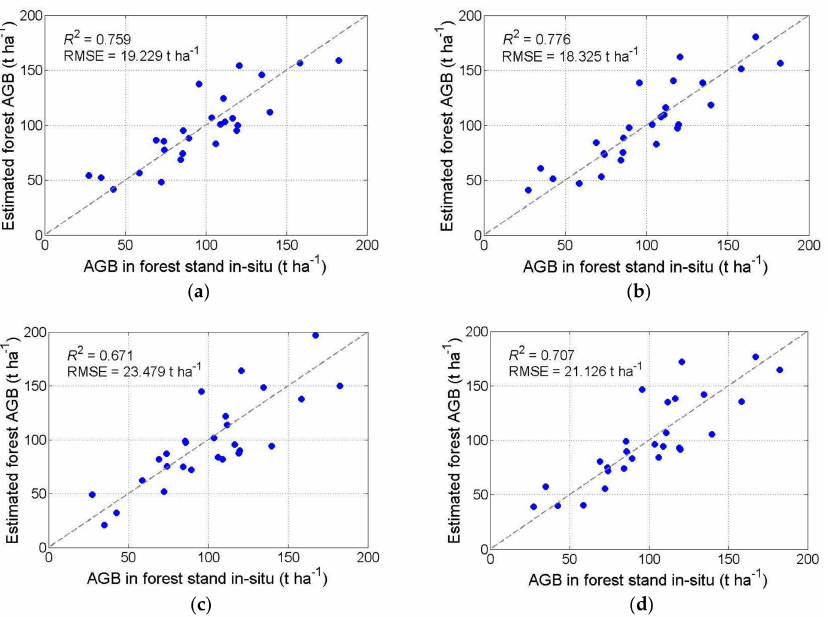
Figure 11. Comparison between in-situ AGB and estimated forest AGB derived from model in 134